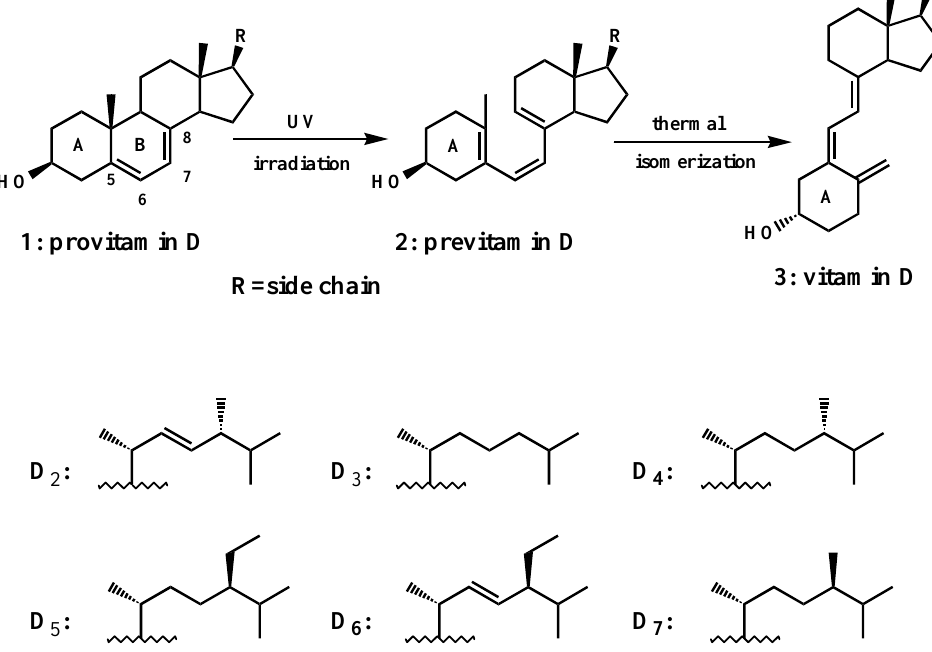
through vitamin D 2 7